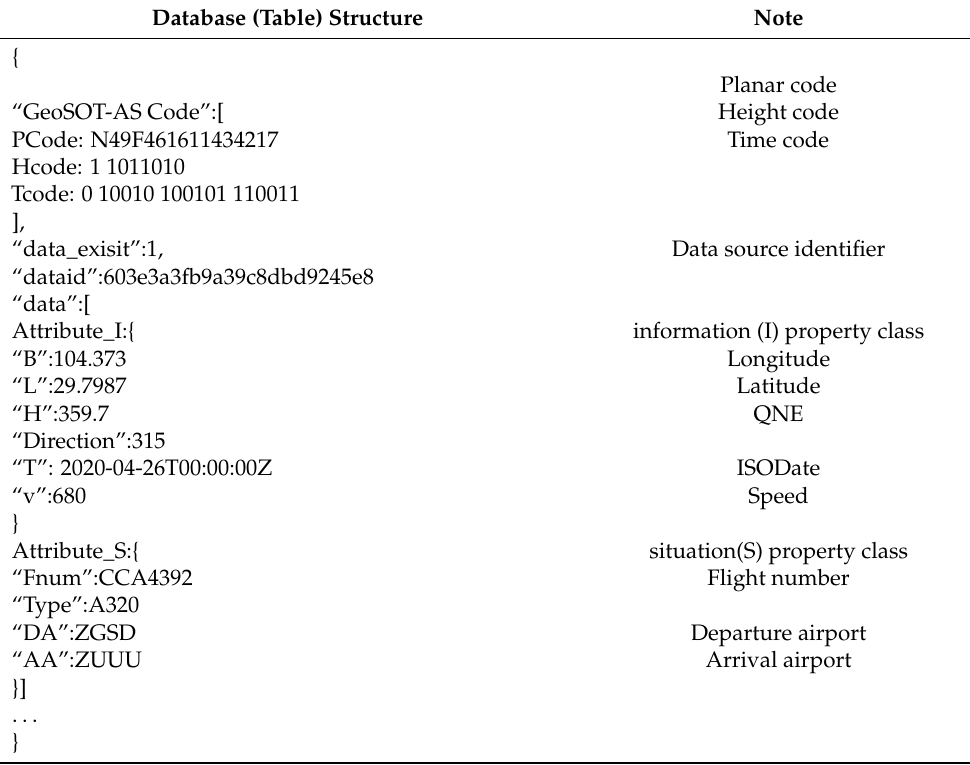
Table 7. ADS-B information structure table under GeoSOT-AS framework.